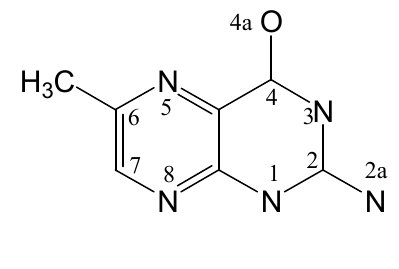
Figure 2. Pterin numbering